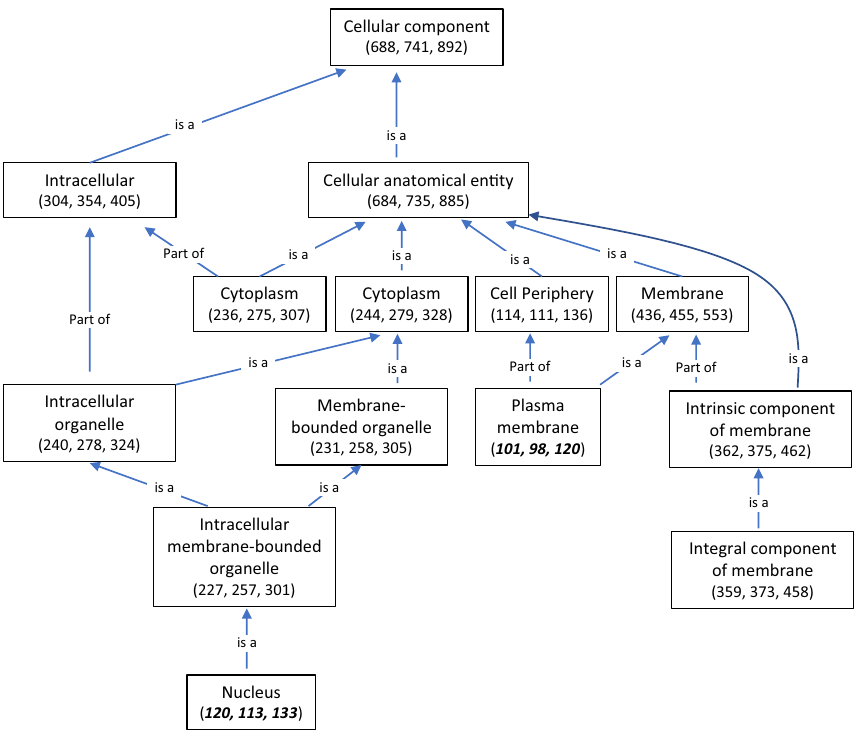
Figure 4. Hierarchical diagram of cellular components according to 892 annotated genes that were differentially expressed under dry and wet treatments in TAM 111 and TAM 112. Numbers in parenthesis indicate the number of genes in each cellular component with the first number indicating the genes in TAM 111 followed by that of TAM 112 and the total number in both cultivars. Numbers in bold and italic font style showed that TAM 111 had a higher number of DEGs for the corresponding cellular component, which were different from the majority where TAM 112 had a higher number of